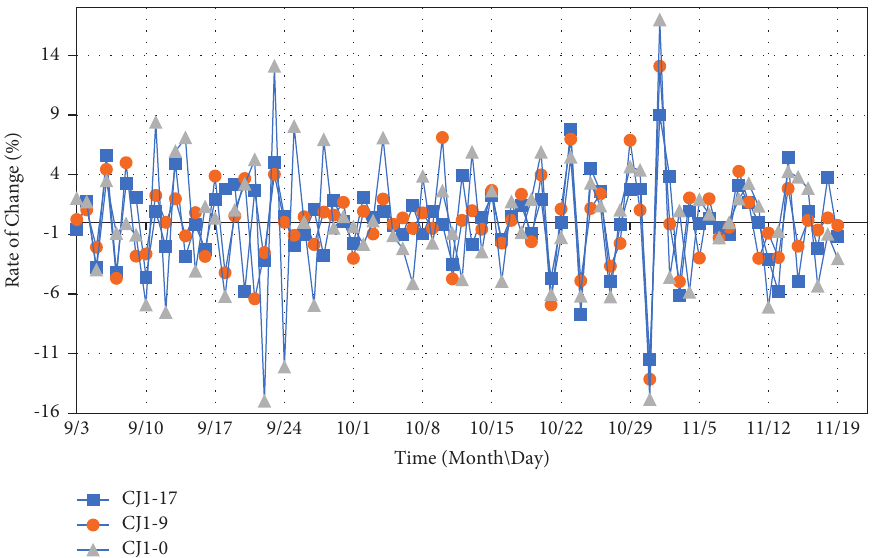
Figure 13: Rate of change of daily settlement (CJ1-17, CJ1-9, and